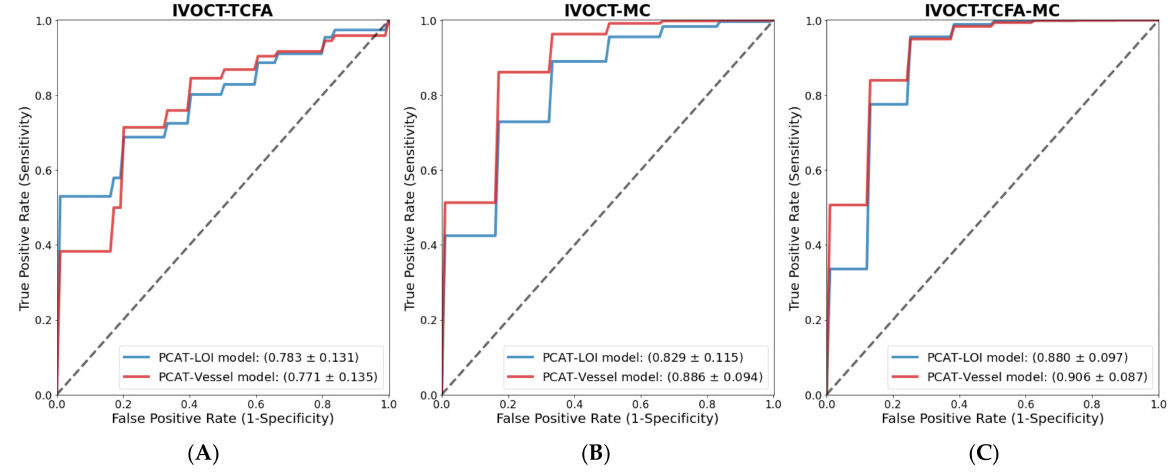
Figure 5. Multivariate analysis of CCTA PCAT-radiomic features associated with IVOCT vulnerable- plaque characteristics on IVOCT. Diagnostic performance obtained from the three-fold cross- validation with 1000 repeats for the identification of ( A ) IVOCT-TCFA, ( B ) IVOCT-MC, and ( C ) IVOCT- TCFA-MC (IVOCT-Vulnerable). The ROC curves of PCAT-radiomics models for PCAT-LOI and PCAT-Vessel are plotted, and the mean AUC and SD are